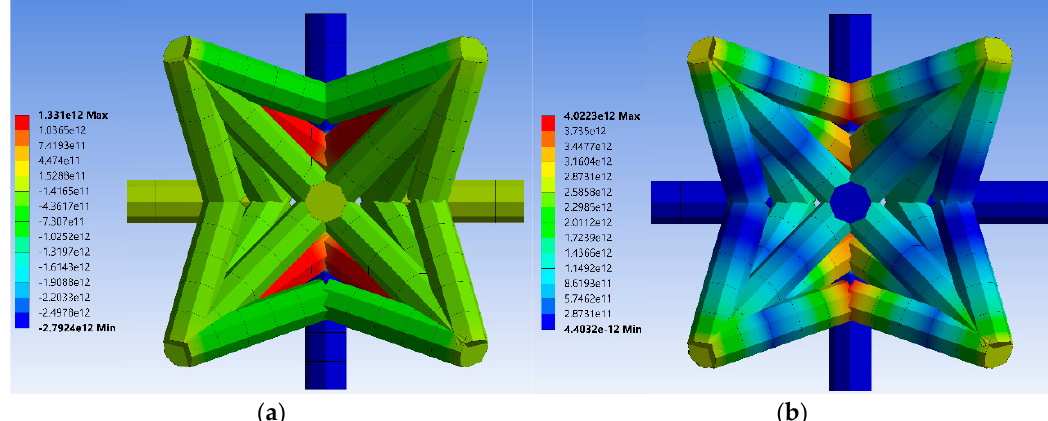
Figure 18. Stress distribution of FE model constructed by Beam 189 elements for 𝜇 = 0.2 : ( a ) normal stress and ( b ) flexural stress. Von-mises equivalent stress and strain, principal strains and stresses, normal and bending stress distributions are shown in Figures S15–S24.